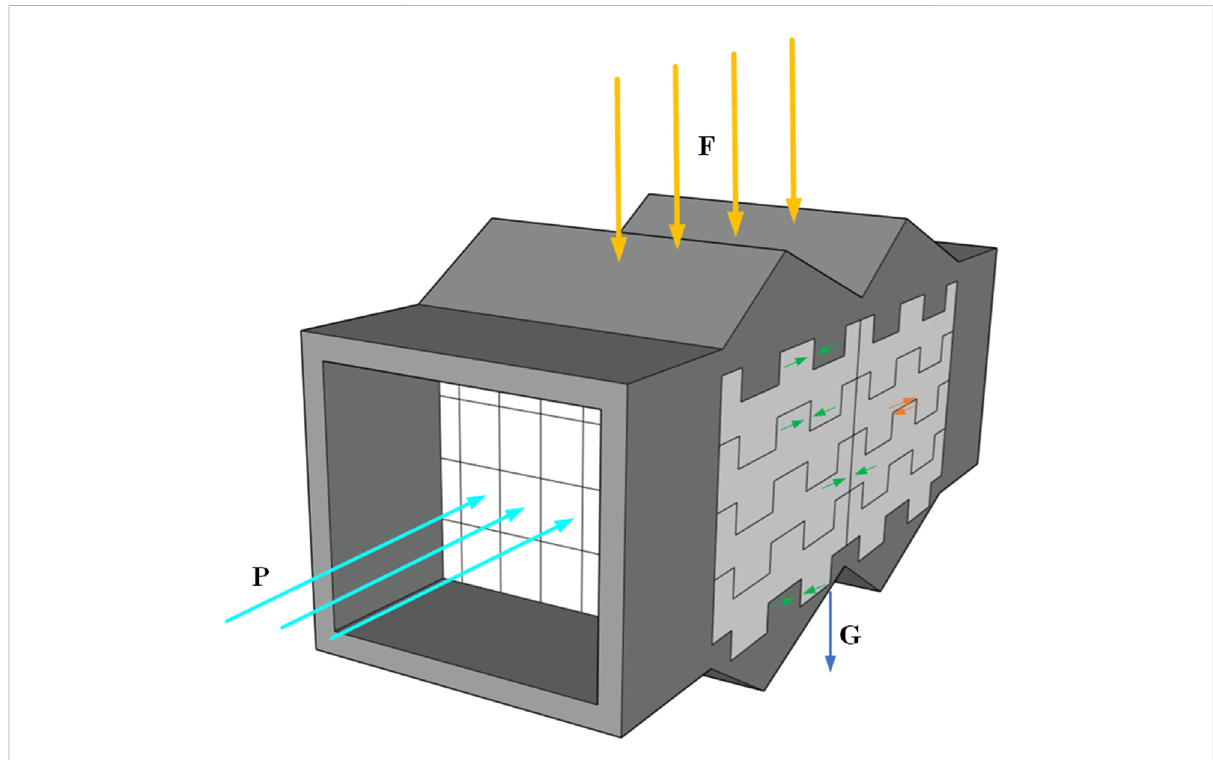
FIGURE 8 Force analysis of 3D printing mine waterproof wall.